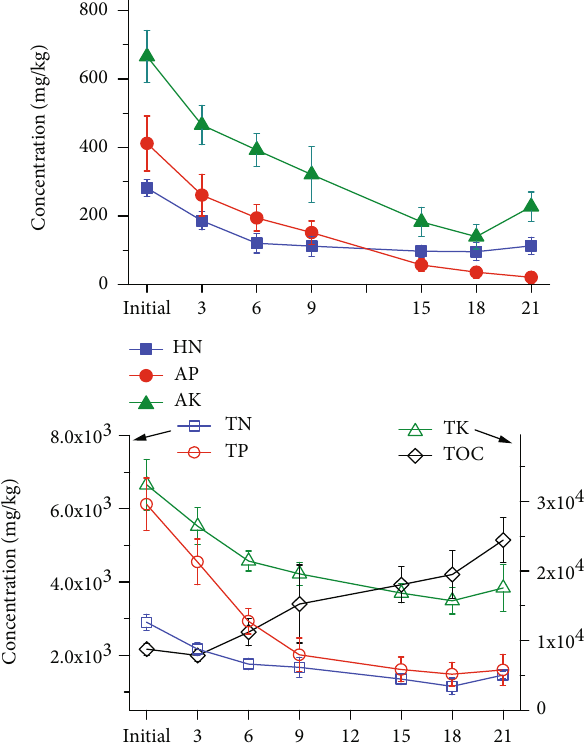
Figure 1: The N, P, K, and TOC in substrate material with the recovered times. The HN, AP, and AK were hydrolyzable nitrogen, available phosphorus, and available potassium; and TN, TP, and TK were total nitrogen, total phosphorus, and total potassium,